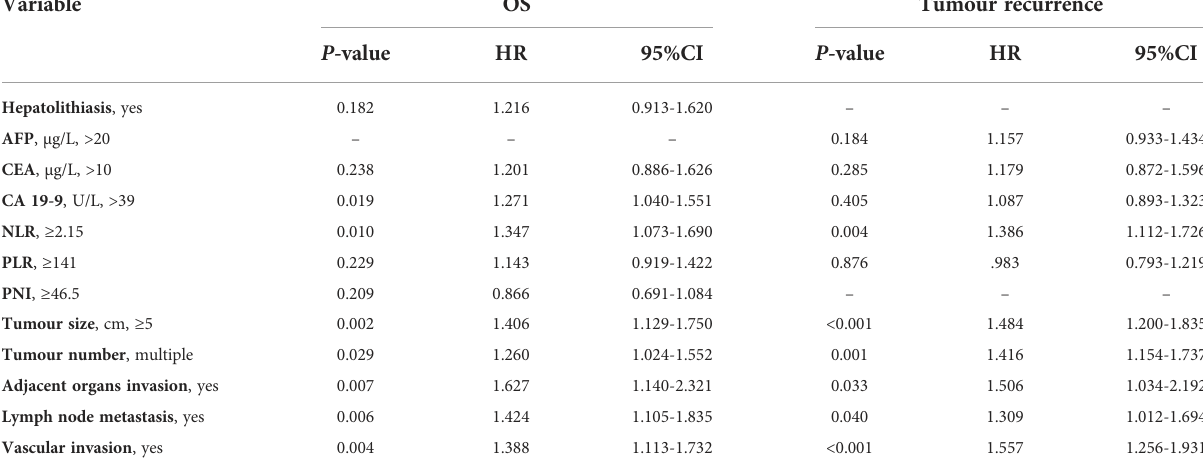
TABLE 3 Multivariate analysis of prognostic factors in ICC patients with HBV infection.